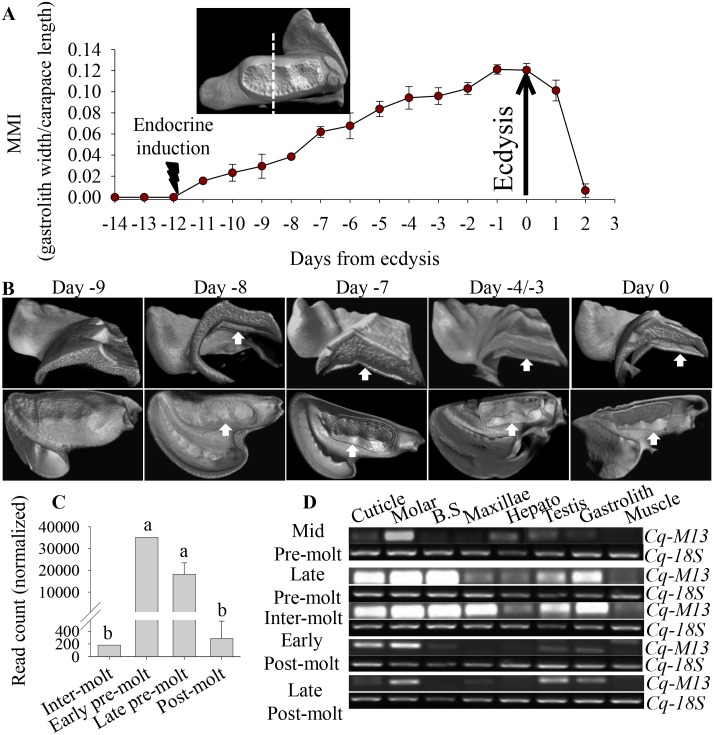
Development of a new molar tooth during an induced molt cycle in an ecdysone-injected male C. quadricarinatus and spatial and temporal expression patterns of the Cq-M13 transcript in vitro and in silico.
A. Changes in molt mineralization index (MMI) during the induced molt cycle following repetitive injections of ecdysone. The x axis is normalized to days from ecdysis. A dashed line on an isolated mandible represents a cut through which a transverse plane is visible (A-top). B. Visualization of the new molar tooth assembly process in the crayfish mandible on days -9, -8, -7, -4, -3 and 0, following ecdysone injection by ex vivo micro-computed tomography. The top and bottom series of images show a view of the transverse and posterior planes of the mandibles correspondingly. White arrows point to the newly formed molar tooth. C. In silico transcriptomic analysis of Cq-M13 read counts from four different molt stages. Different letters above columns represent statistically significant differences (p < 0.05 ± SE). D. Agarose gels showing RT-PCR products demonstrating spatial and temporal expression patterns of the Cq-M13 transcript in cuticle-, molar-, basal segment (B.S.)-, maxillae- and gastrolith-forming tissues, as well as in hepatopancreas (Hepato) and testis.